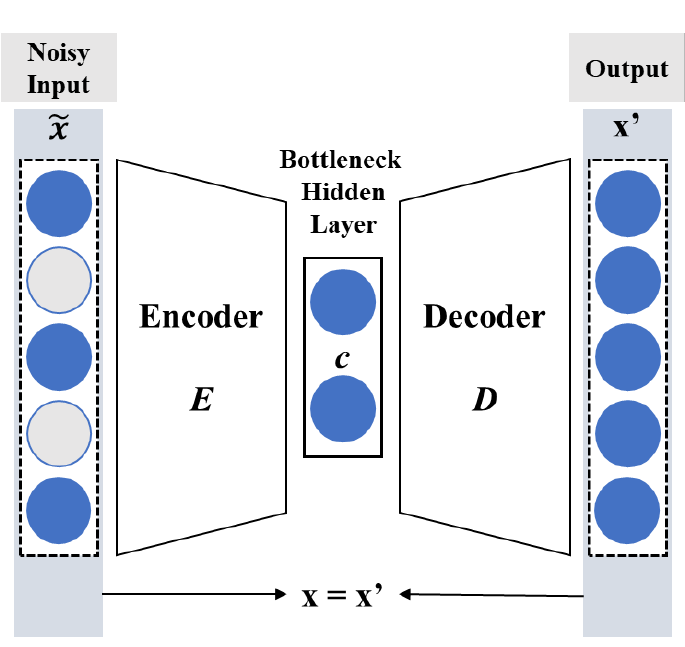
Figure 4. Architecture of the conventional denoising autoencoder.